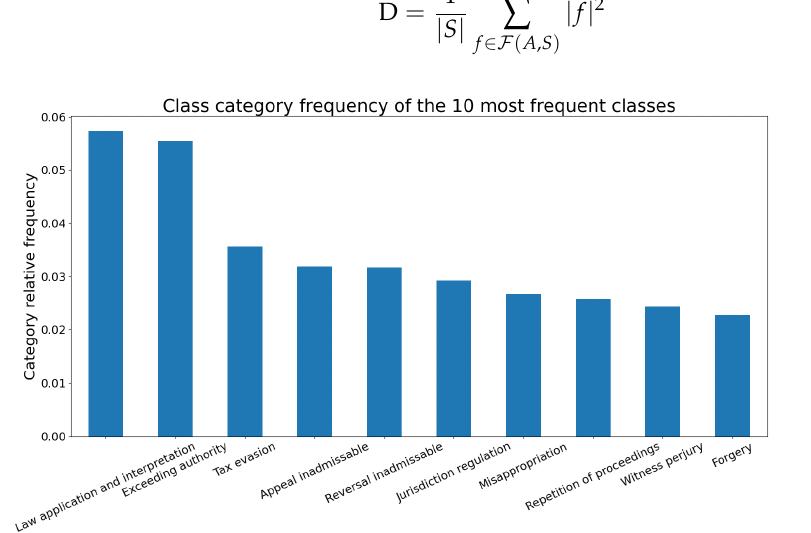
Figure 1. The 10 most-frequent categories in the AreiosPagos dataset. The x-axis corresponds to the category labels. The y-axis corresponds to the absolute frequency of each category. Original Greek labels: Νόμου Εφαρμογή και ερμηνεία, Υπέρβαση εξουσίας, Φοροδιαφυγή, Εφέσεως απαράδεκτο,